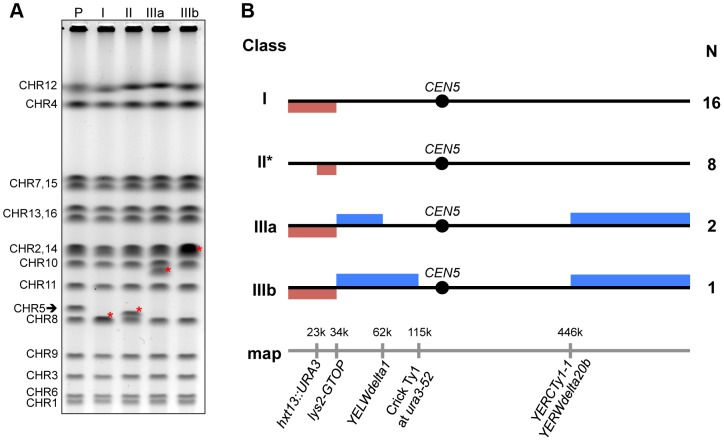
Classes of GCRs associated with the highly transcribed G4 DNA motif.A. PFGE analysis of different classes of GCR events. The full-length chromosomes of representative 5-FOAR CanR clone derived from the top1Δ strain containing the pTET-lys2-GTOP cassette are separated out by size. Classes I, II, IIIa and IIIb are described in the text. The chromosomes in the parental strain (P) are indicated to the left and the arrow indicates the normal (unrearranged) CHR5. The locations of novel chromosomal bands in each sample are indicated by red asterisks. B. Summary of the array-CGH analyses. The red and blue bars indicate the loss and the gain of the copy number of the corresponding regions of CHR5, respectively. The coordinates are approximate and correspond to the S288c reference genome sequence according to Saccharomyces Genome Database. The relevant genomic features are indicated at the bottom of the figure. The locations of relevant solo LTRs and full length Ty retrotransposons are indicated. At coordinate ∼115,000, the ura3-52 allele with a Crick-oriented insertion of a Ty1 element is present in this strain background. The quantitative analysis of the PFGE in Fig. 2A and the detailed CHR5 gene dosage plots for the GCR classes are shown in Fig. S2. The detailed breakpoint nucleotide sequence of the segmental deletion in Class II events (*) is shown in Figure S3.